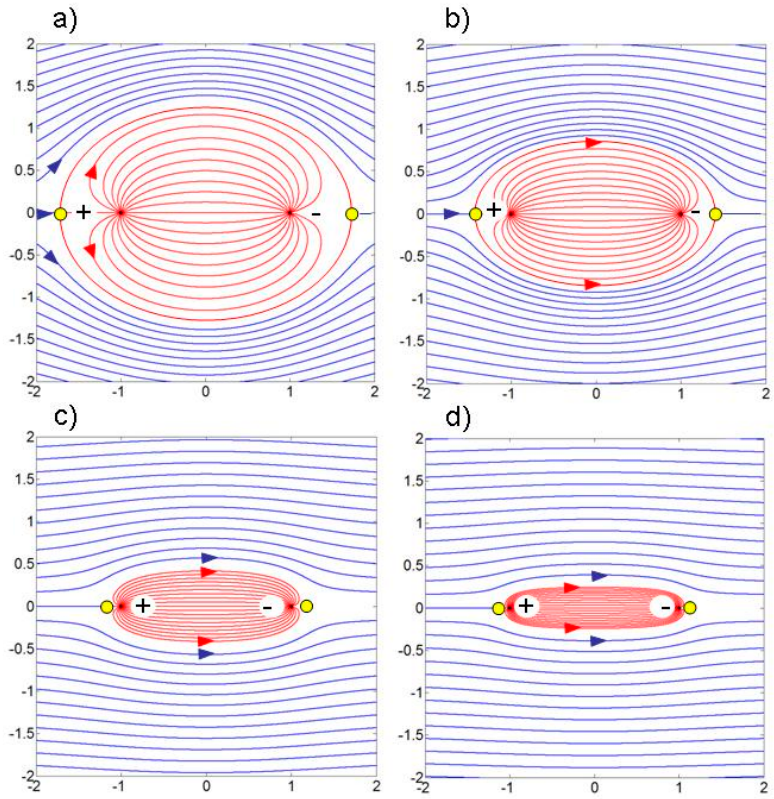
Figure A7. Rankine body outlines effective sweep region for injection fluid (red curves). Well strengths of the doublet are constant and equal for all cases ( m * injector = +1 and m * producer = − 1). Rankine body region is flattened by faster far-field flow-rates: ( a ) U x * = 1; ( b ) U x * = 2; ( c ) U x * = 5, and ( d ) U x * = 10 [61].